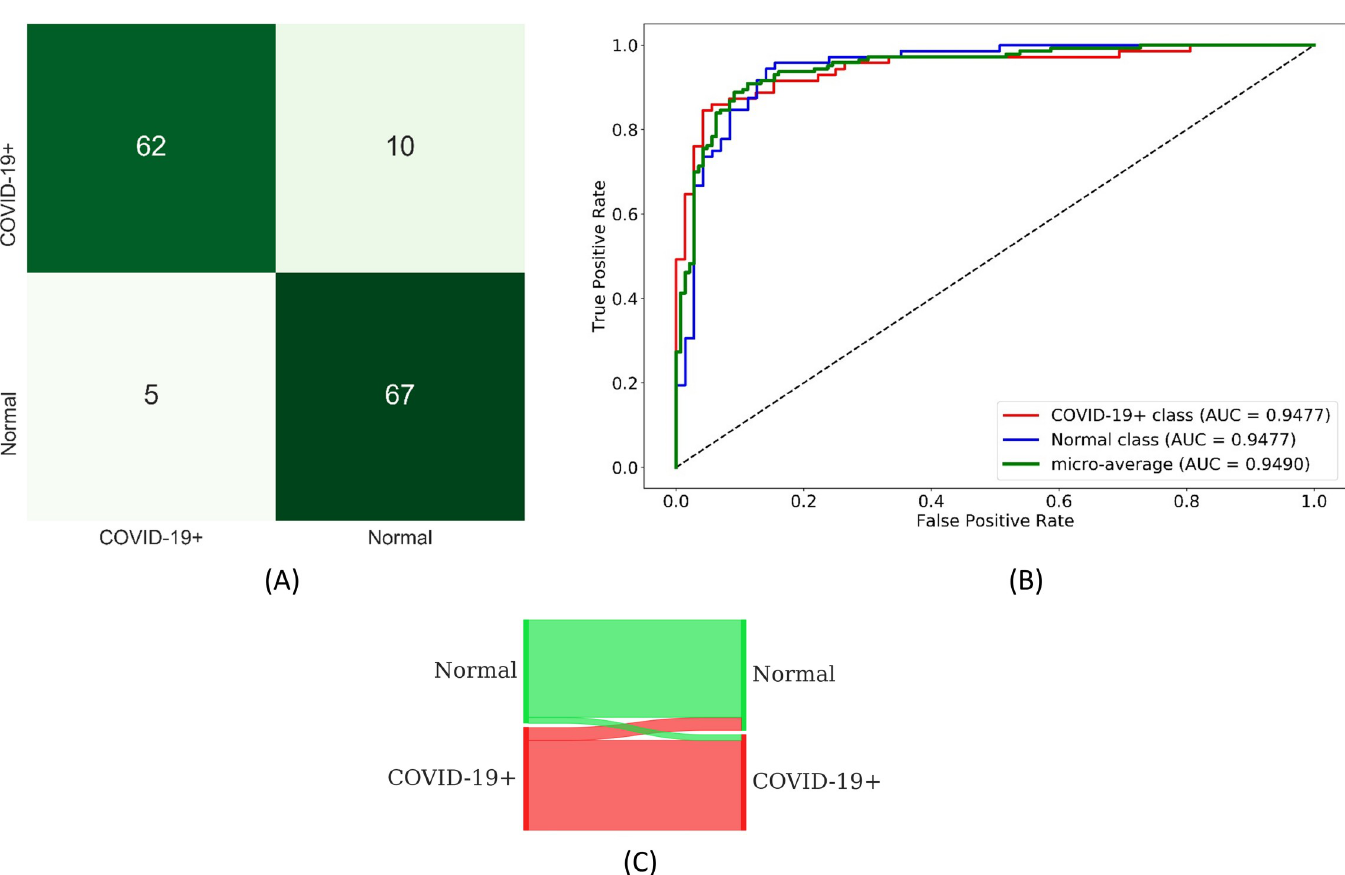
Fig 11. Performance achieved using the ResNet-18 model during fine-tuning for COVID-19 detection. (A) Confusion matrix; (B) ROC curves; (C) Normalized Sankey flow diagram.